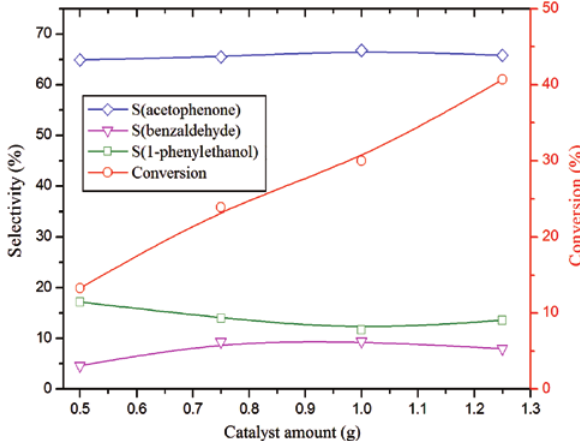
Figure 6: Effect of catalyst amount on the conversion and product selectivities. Reaction conditions: (H